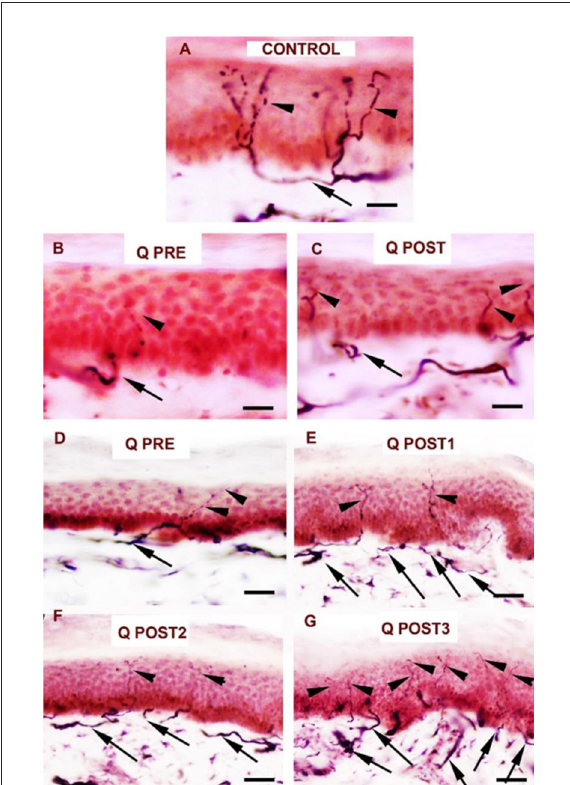
FIGURE7 Staining for PGP9.5 in control skin, NPDPN Q + SOC and PDPN Q + SOC before and after application of Capsaicin 8% patch